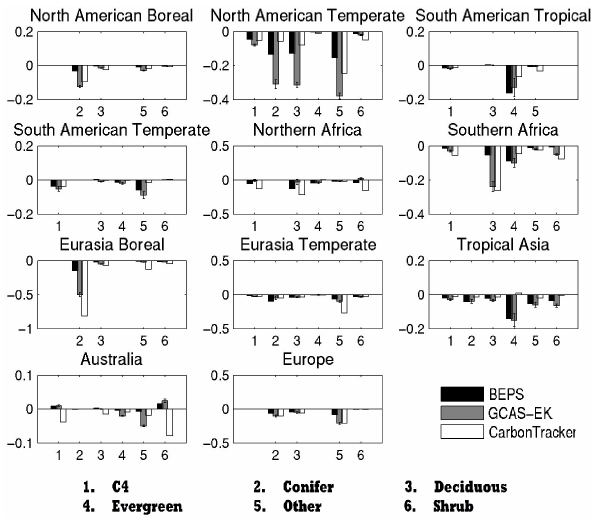
Figure 8. Annual mean carbon budgets (PgCyr − 1 ) on areas with six BEPS plant function types in Transcom regions from 2002 to 2008. The errors of GCAS-EK fluxes are the root mean square er- rors of the